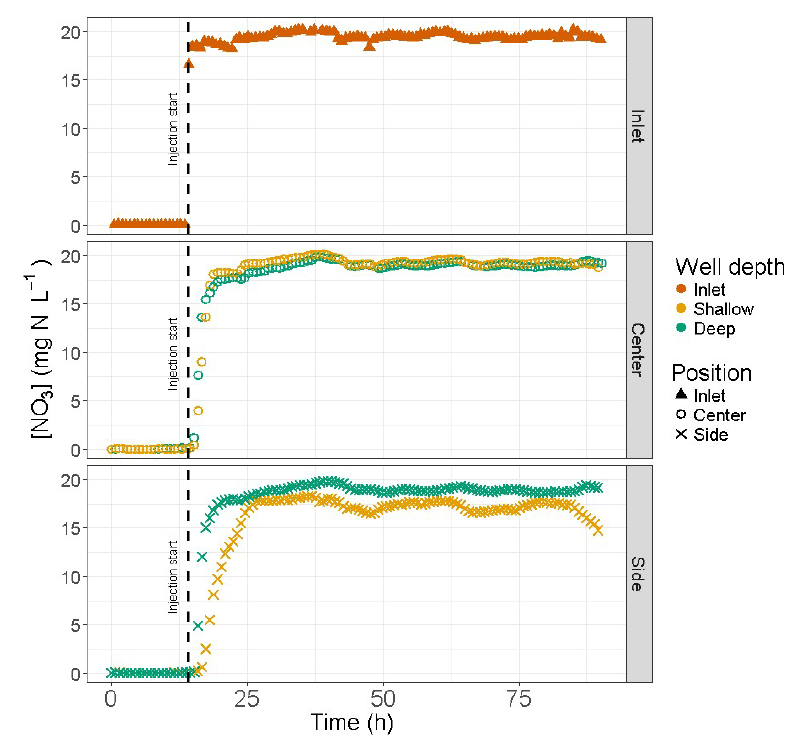
Figure 3. Nitrate concentration at inlet and wells near the inlet before and during the KNO 3 injection. Color indicates bioreactor inlet and depth of sampling wells, and shape indicates the position of the well transect (centerline or near the side